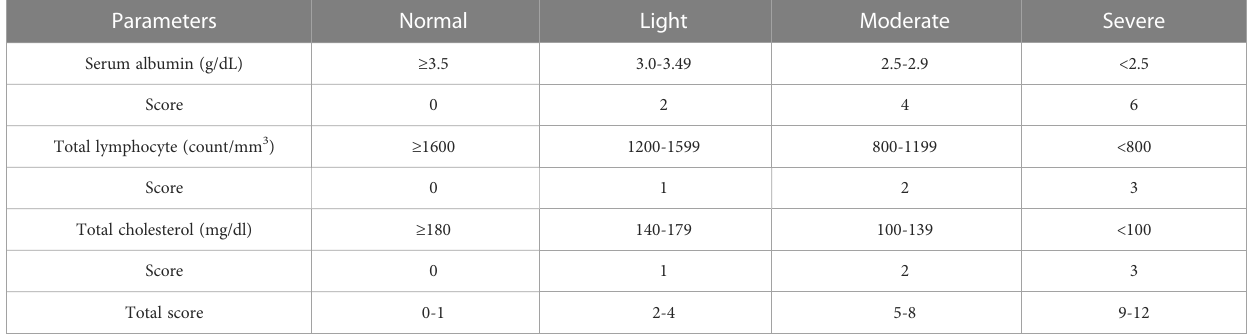
TABLE 1 Nutritional assessments using the CONUT scoring